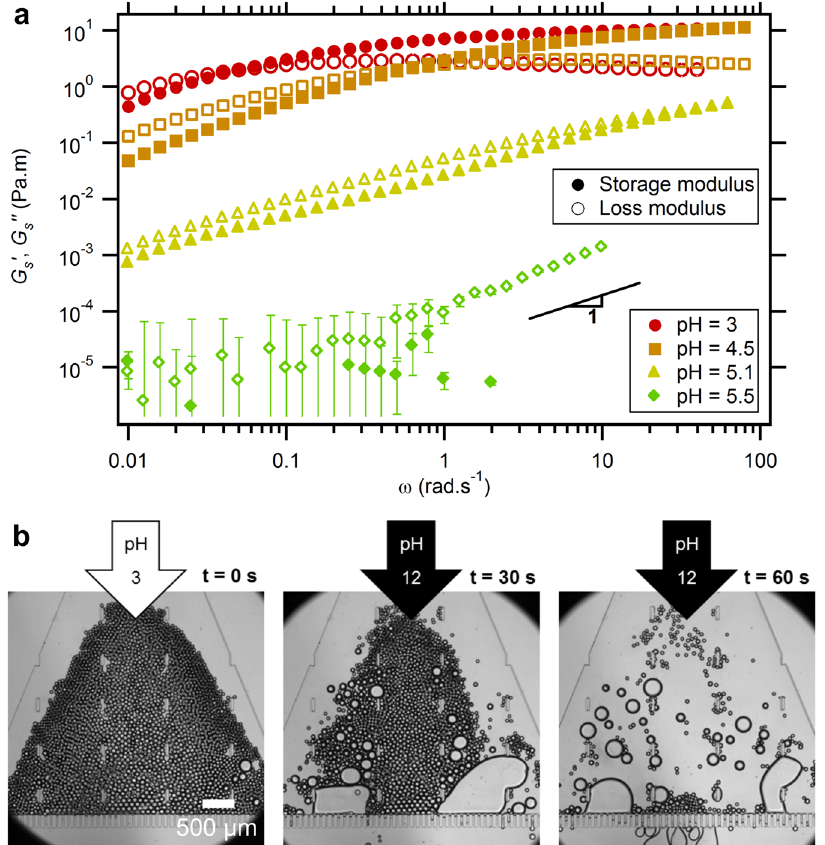
Figure 4. ( a ) Frequency sweeps (at strain amplitude = 0.1%) performed on a PMAA-PPO membrane, at several pH from 3 to 5.5. The surfacic storage modulus ′ G is plotted with filled symbols, and the loss modulus ″ G s open symbols. Error bars are shown when larger than markers size. pH increase induces a softening of the membrane. ( b ) Left: capsules stored at pH = 3. Center and right: pH = 12 water flow induces membrane vanishing and inner fluid